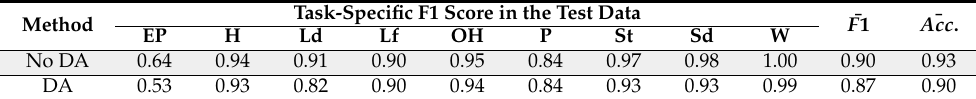
Table 8. Cross-scenario classification performance. Abbreviations: EP: electrical panel, H: hoisting, Ld: ladder, Lf: lifting; OH: overhead; P: pushing; St: sitting; Sd: standing; W: walking. Task-Specific F1 Score in the Test Data